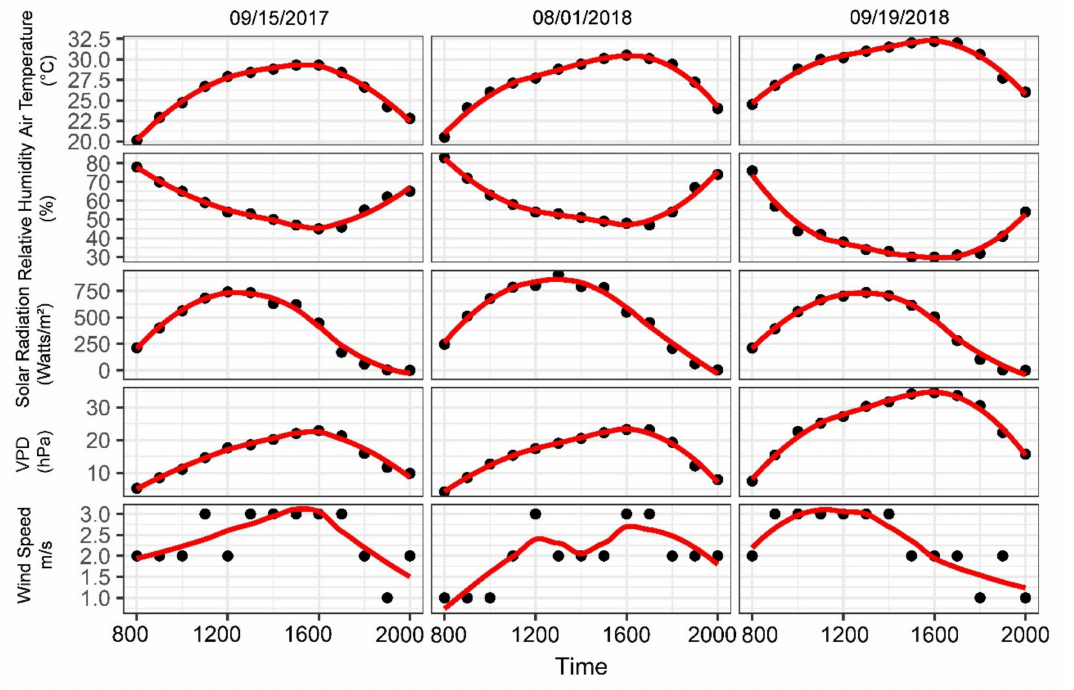
Figure 9. Air temperature, relative humidity, solar radiation, vaper pressure deficit (VPD), as well as wind speed for 15 September 2017, 1 August 2018, and 19 September